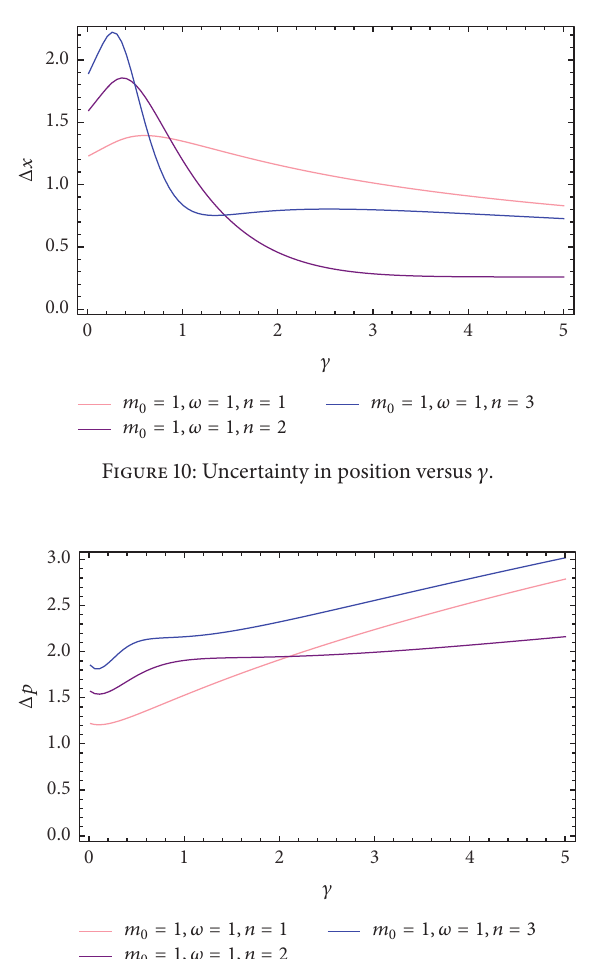
Figure 11: Uncertainty in momentum versus 𝛾 .